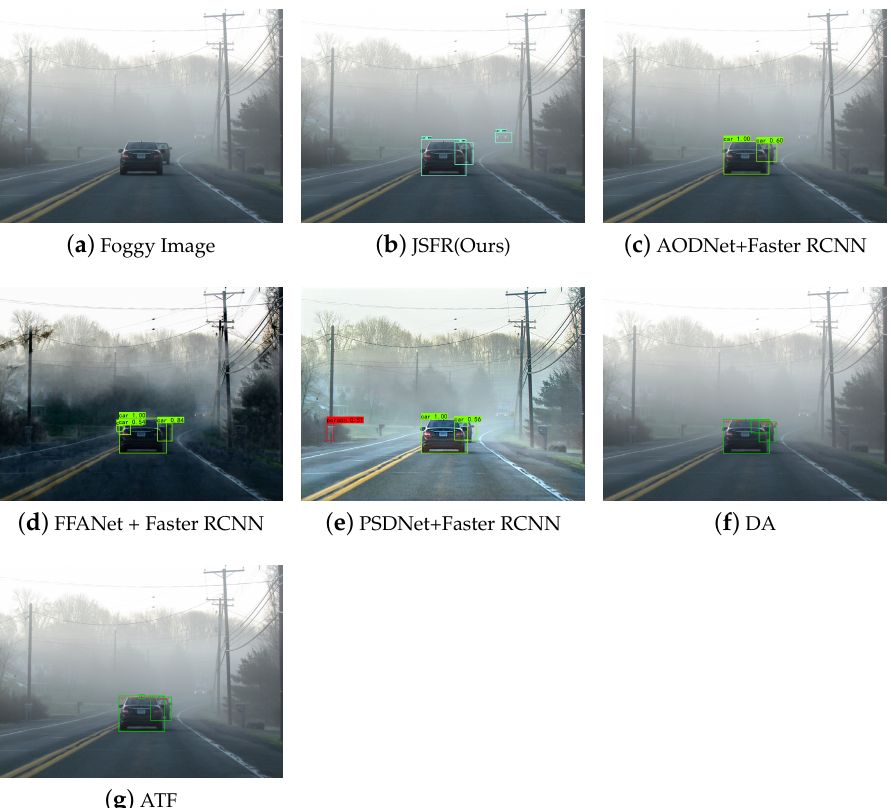
Figure 11. Testing results on Foggy Driving Dataset about JSFR , combination methods including AODNet + Faster RCNN , FFANet + Faster RCNN , and PSDNet + Faster RCNN , and domain adaptive methods including DA and ATF . (Electronic zoom-in